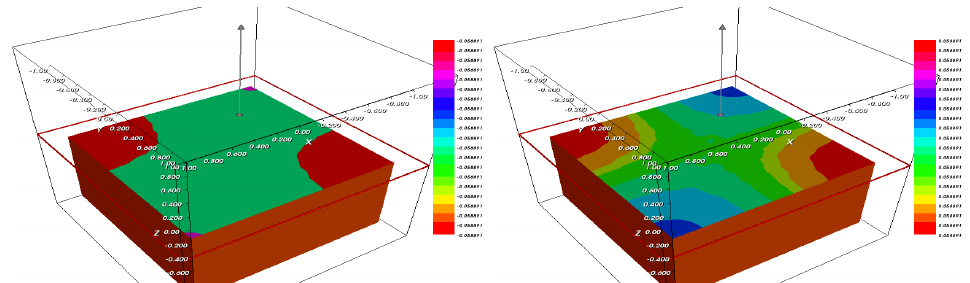
Figure 4. The fraction ϕ ( left ) and ψ ( right ) after T =